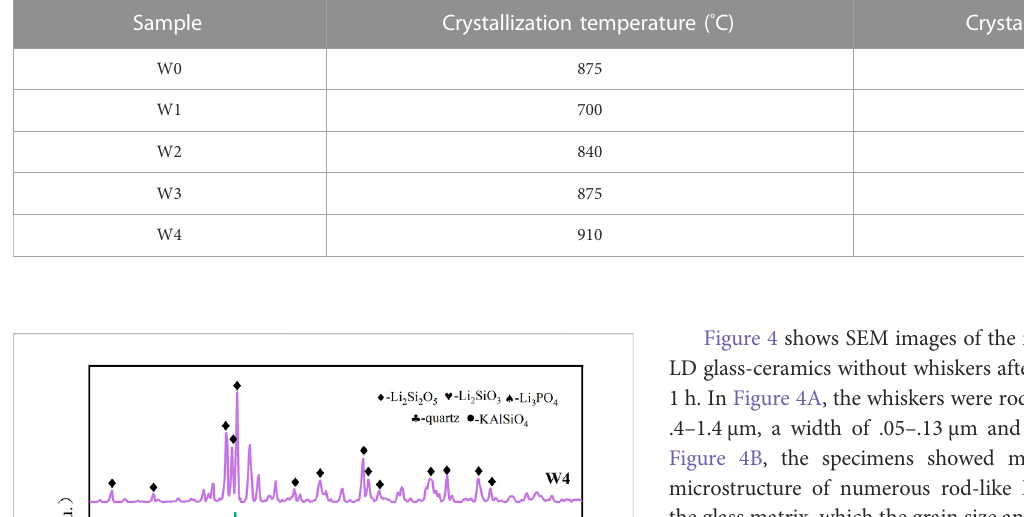
TABLE 4 Heat treatment processes of micro-nano-LD whisker-reinforced glass-ceramics. Sample